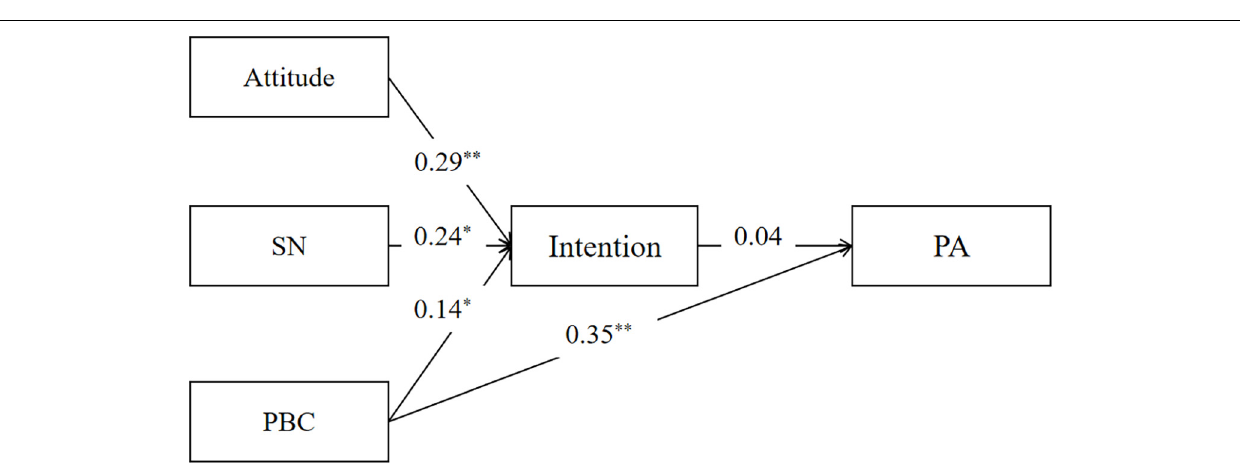
influential on the intention-behavior gap among college